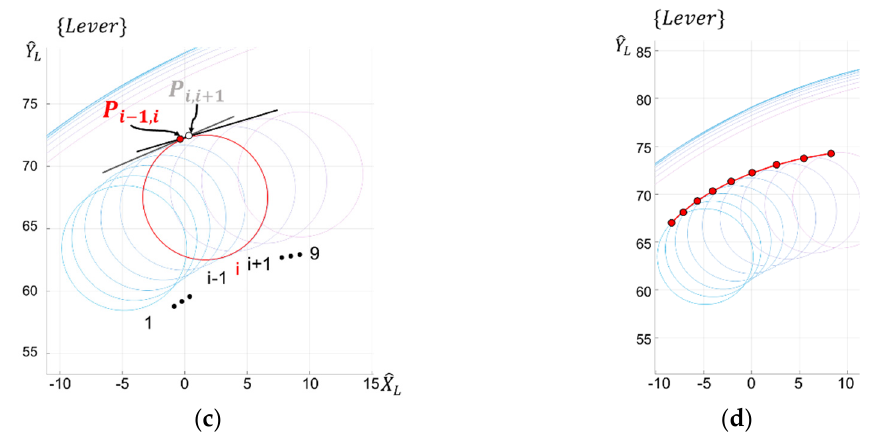
Figure 5. Design processes of the PC1. The units of x- and y-axes are mm: ( a ) Parameters to calculate transformation matrices at each representative pivot position; ( b ) spring followers are represented in the lever coordinate system; ( c ) common circumferential lines and points and principle to choosing the representative contact points; ( d ) the representative contact points of each spring follower and Hermite spline-based PC1.